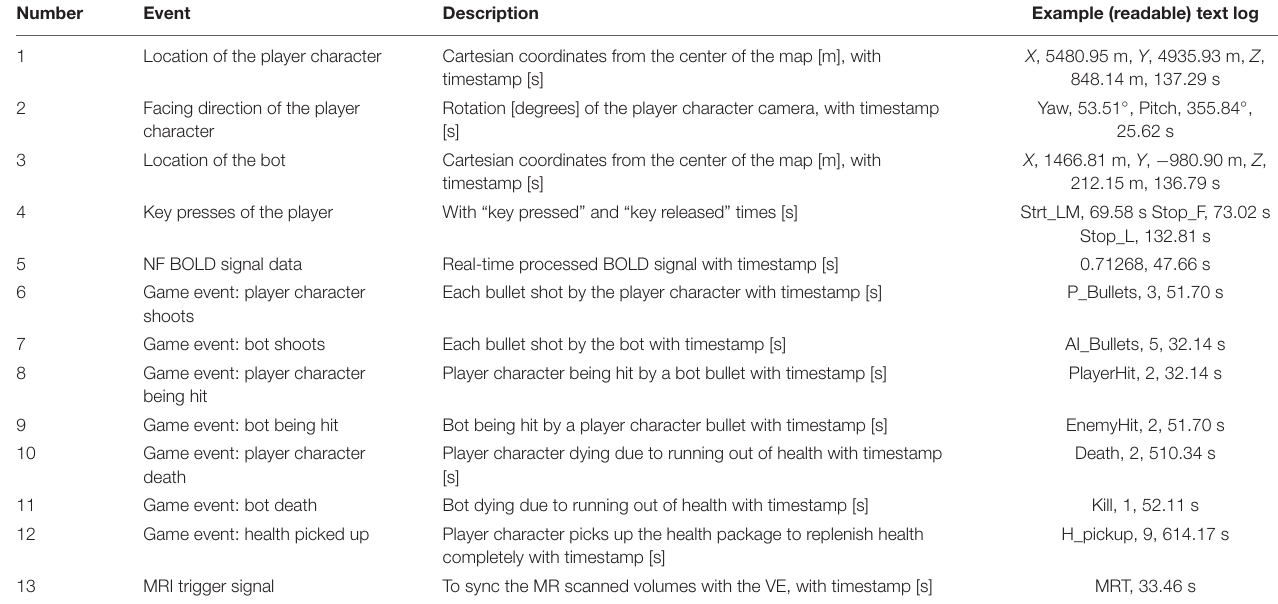
TABLE 1 | Predefined events logged by the